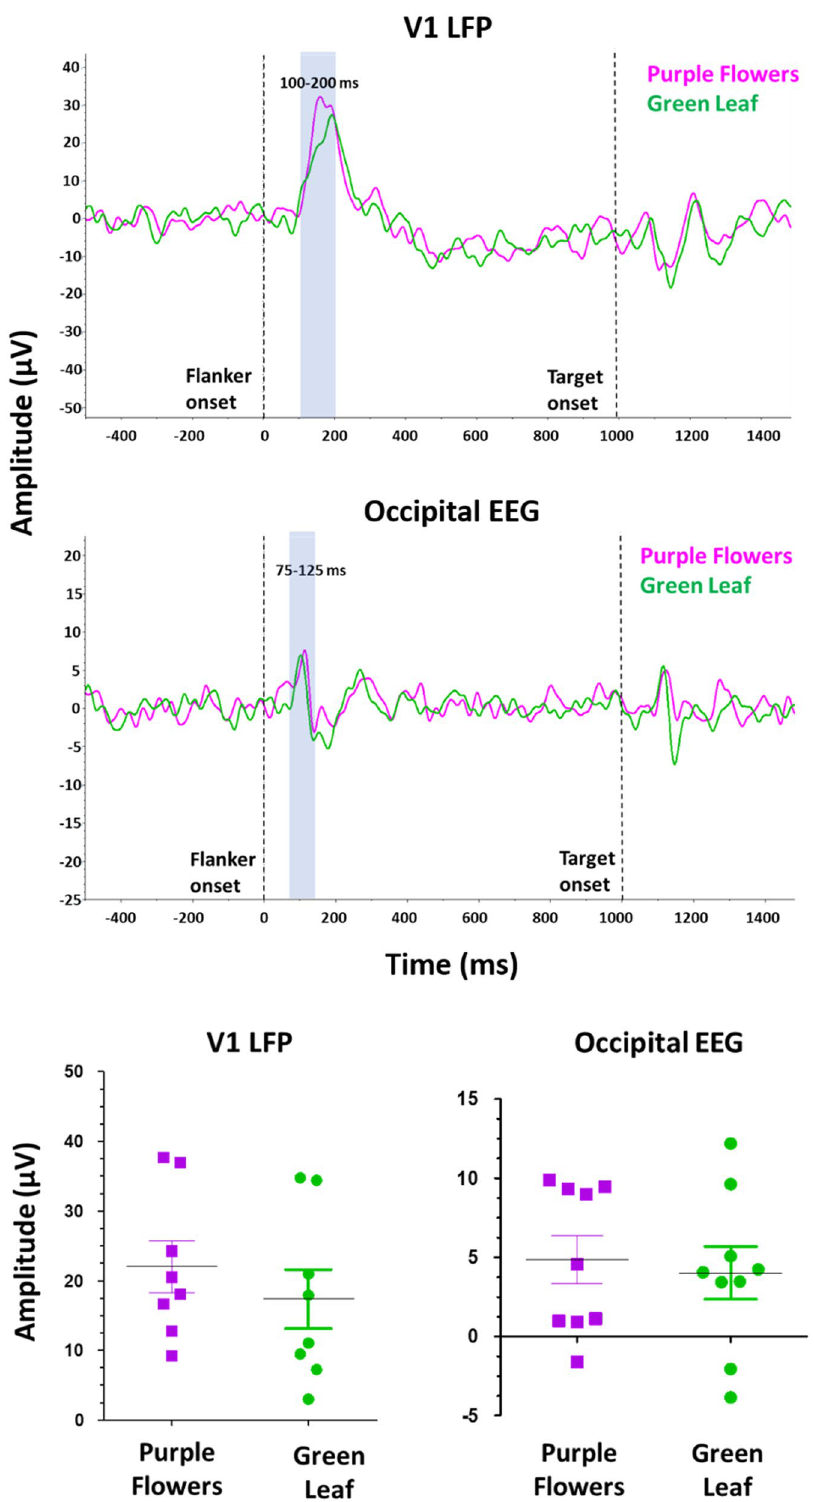
Figure 5. Stimulus–response comparison of VEPs for electrodes located in visual areas by trial type. Top panel: V1 LFP electrode. Middle panel: VEPs of the occipital EEG. Bottom panels: average amplitude of the V1 LFP electrode at the 100–200 ms time window (left) and occipital EEG at the 75–125 ms time window (right). First vertical dashed line (time zero) corresponds to the flanker stimulus presentation and second vertical dashed line (at 1000 ms) represents the target stimulus